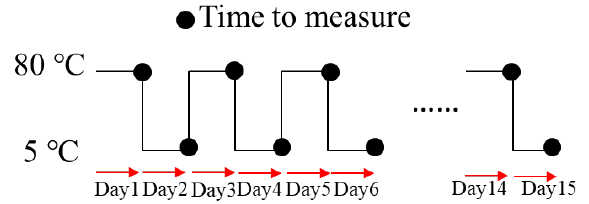
Table 2. Percentage change in Z in the 25 °C and 80 °C degradation tests.